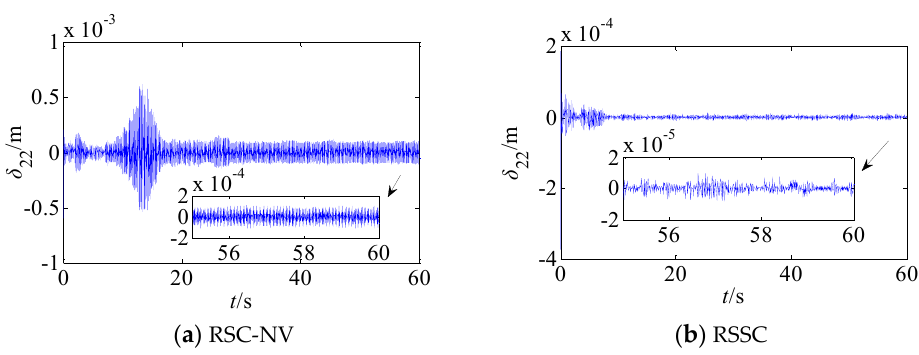
Figure 11. The second mode coordinates of the flexible link